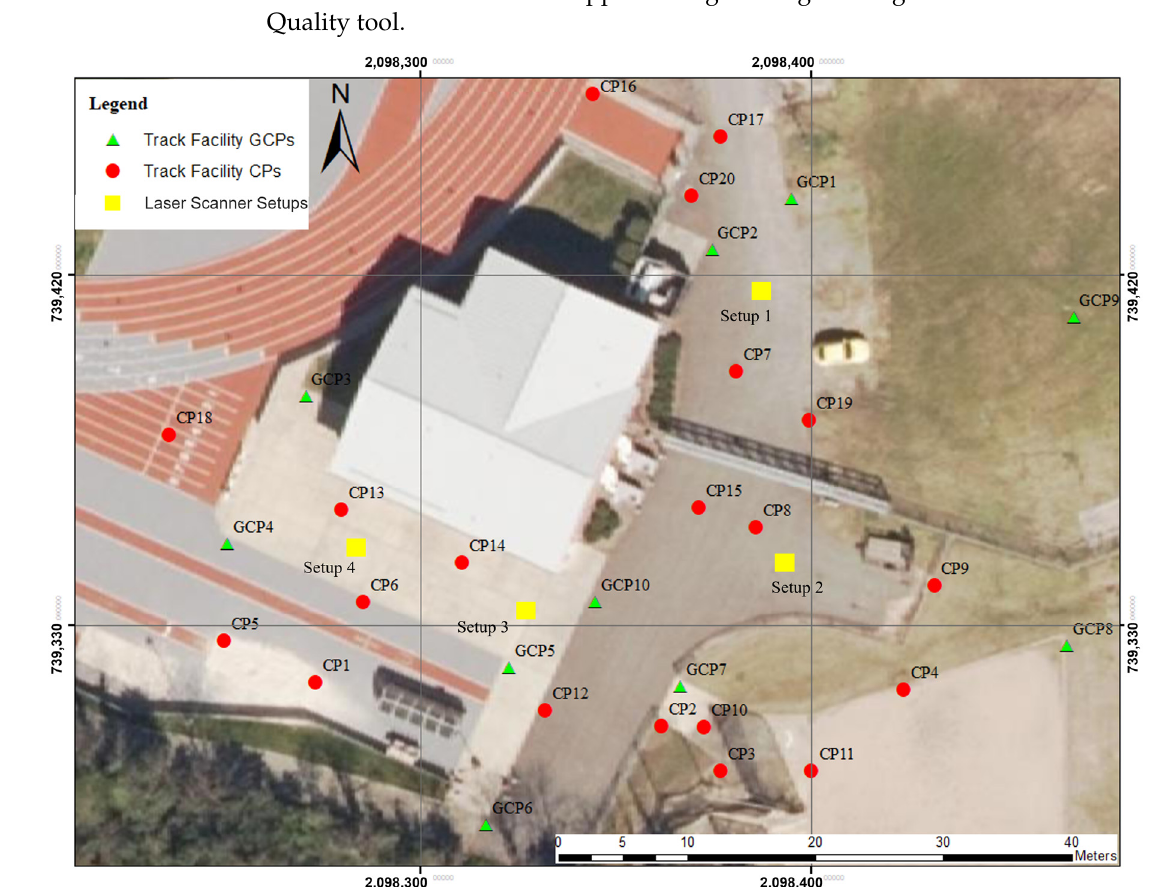
Figure 3. Layout of GCPs and CPs in NCSU track facility site.